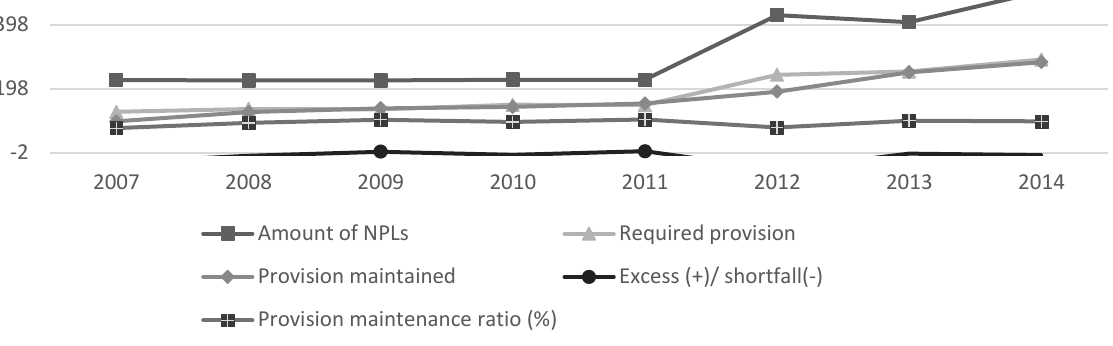
Figure 3. Required provision and provision maintained by all banks